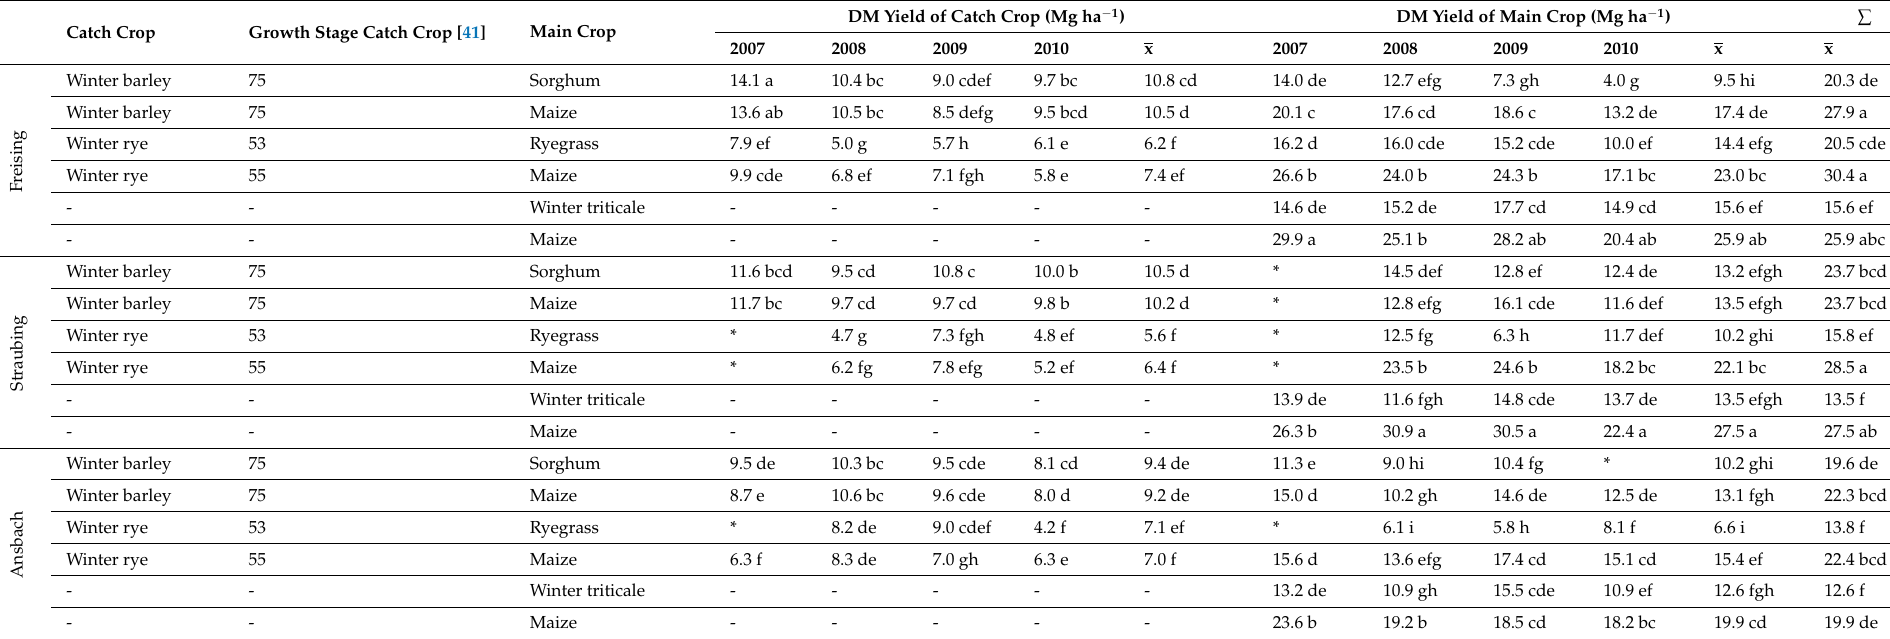
Table 5. Dry matter yields at the experimental sites. Column-wise differences marked with letters. Values marked with * Could not be determined due to game browsing or technical